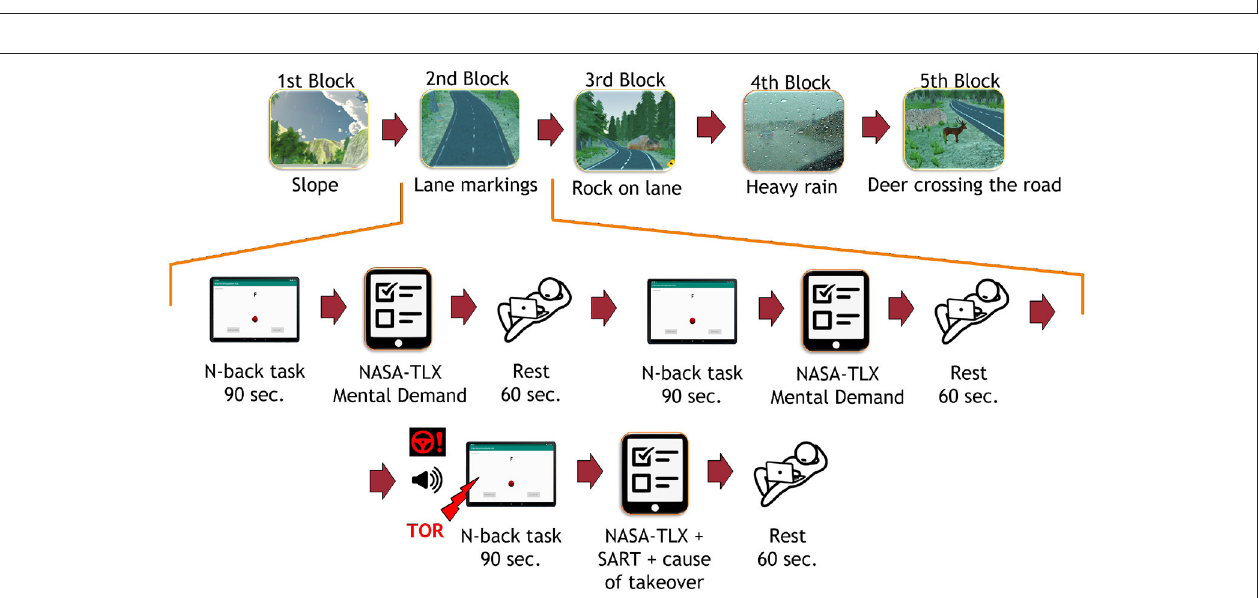
FIGURE 4 | Top: The experimental procedure during the whole driving session. Captions below images correspond to the cause of takeover request sent by the car in each block. Bottom: The experimental procedure in one block of the main driving session. TOR, Take-Over Request; SART, Situation Awareness Rating Technique. The TOR did not appear in the same position in each